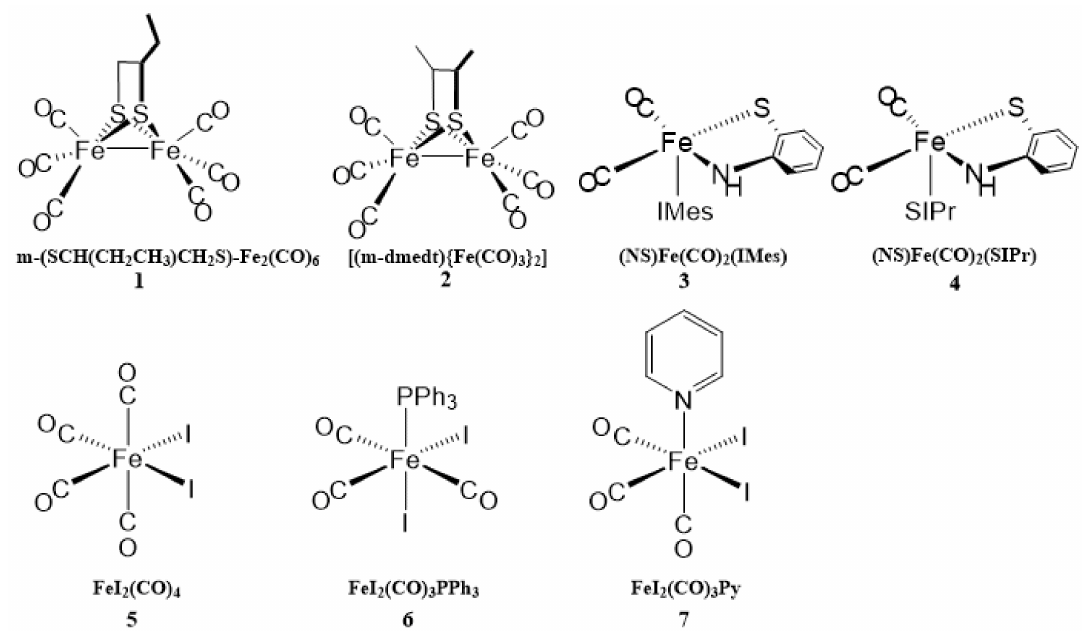
Figure 1. Chemical structures of hydrogenases 1 – 7